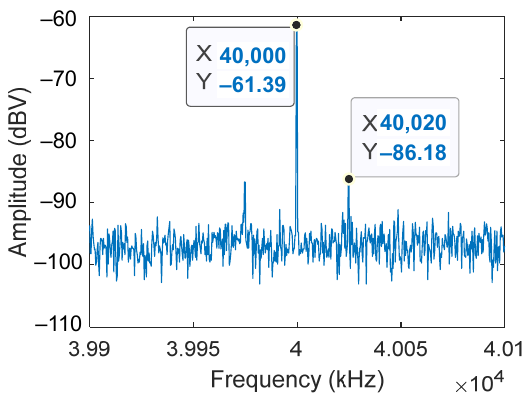
Figure 10. Reference of the calibration obtained with the heterodyne interferometer for an excitation of the PZT transducer of 20 V and 20 kHz. Signal on the photodetector PD2. A ratio of about 25 dB between the zero and the first harmonic was achieved. It led to 0.1 rad over a 10 cm length of fiber that was 215 n ε , measured with the heterodyne interferometer at 20 kHz and 20 V of amplitude.